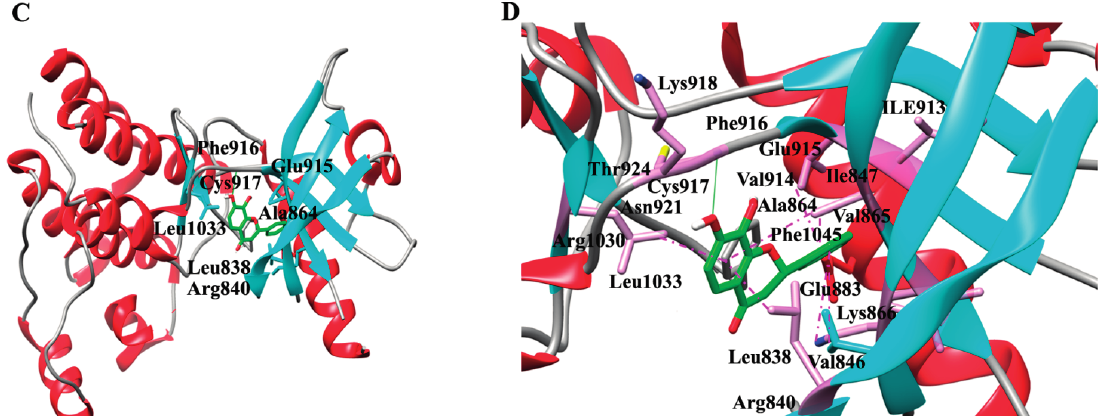
Figure 1. Interaction and binding mode of 7,8-dihydroxyflavone (7,8-DHF) with TrkB and VEGFR2. ( A ) Docking of TrkB (ribbon structure) with the 7,8-DHF (wire-frame) showing critical residues involved in interaction; ( B ) Enlarged view of the interaction pocket within 5.5 Å around the ligand, 7,8-DHF-TrkB complex; ( C ) Docking of VEGFR2 (ribbon structure) with the 7,8-DHF (wire-frame) highlighting important residues involved in interaction; ( D ) Enlarged view of the interaction pocket within 5.5 Å around the ligand, 7,8-DHF-VEGFR2 complex. Red ( α -helix), cyan ( β -sheets) grey (random coil). Green strong line denotes the hydrogen bonding and pink dashed line reflects pi –sigma interactions and stacking. The images were generated with the Discovery Studio 4.0 Client (Accelrys, Inc., San Diego, CA,